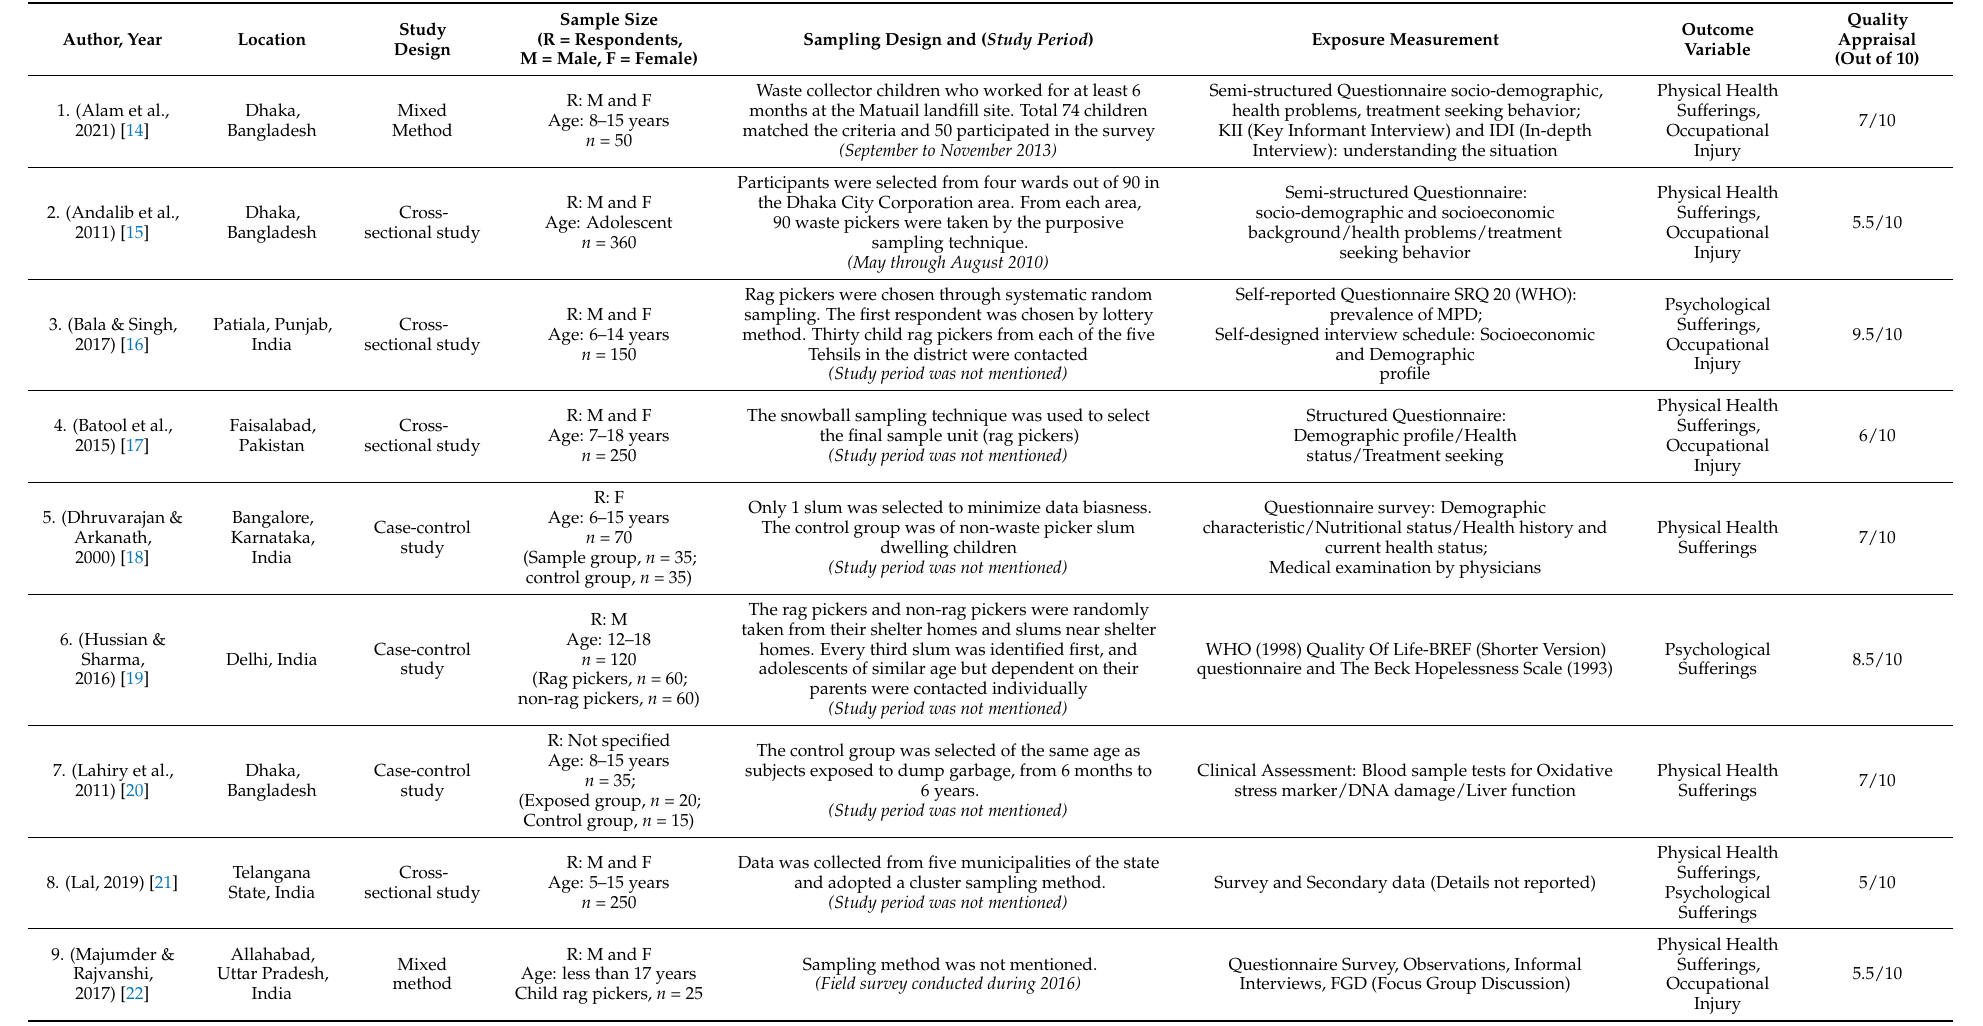
Table 3. Characteristics of included